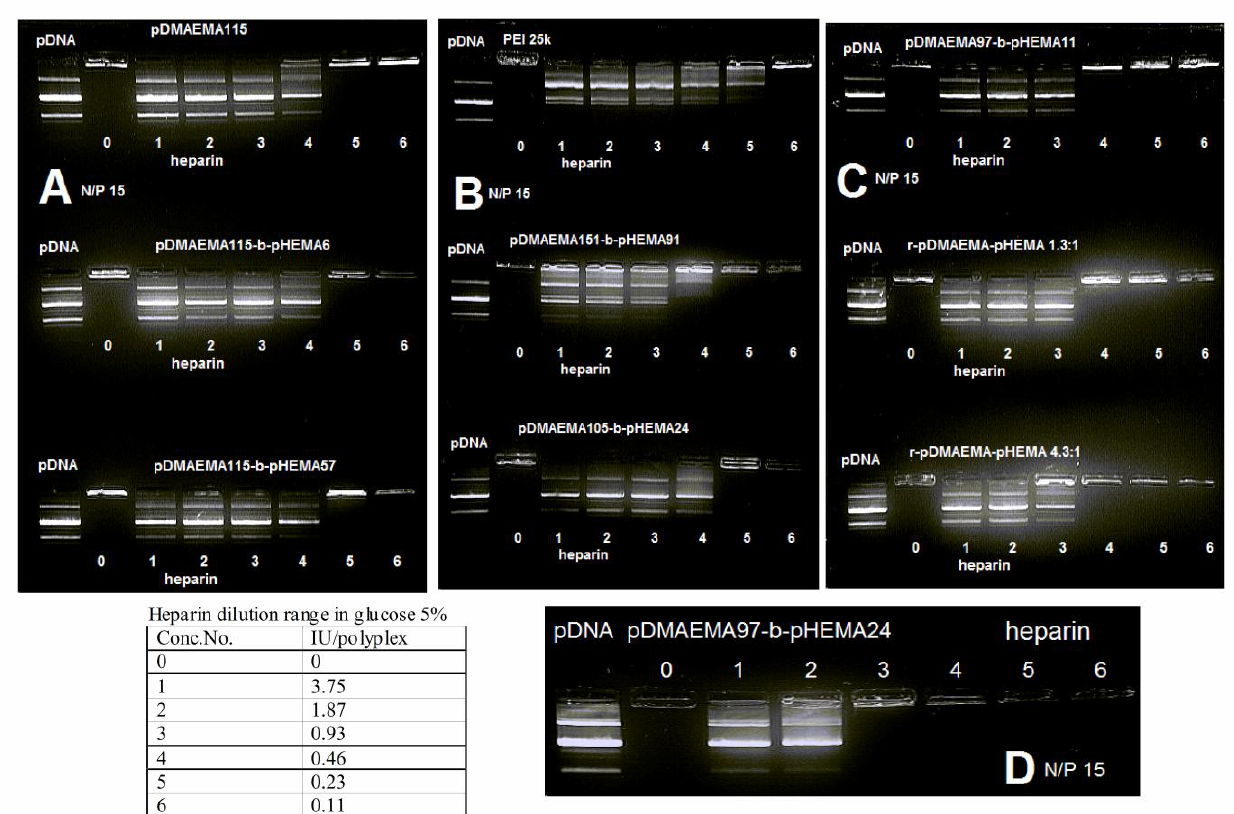
Figure 4. A , B , C , D . Heparin assay: displacement of DNA from polyplexes with polyanion on agarose